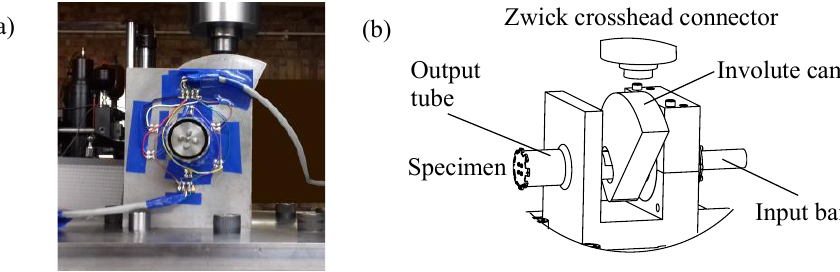
Figure 4 : QSTS: (a) Image of system , and (b) schematic with key features.